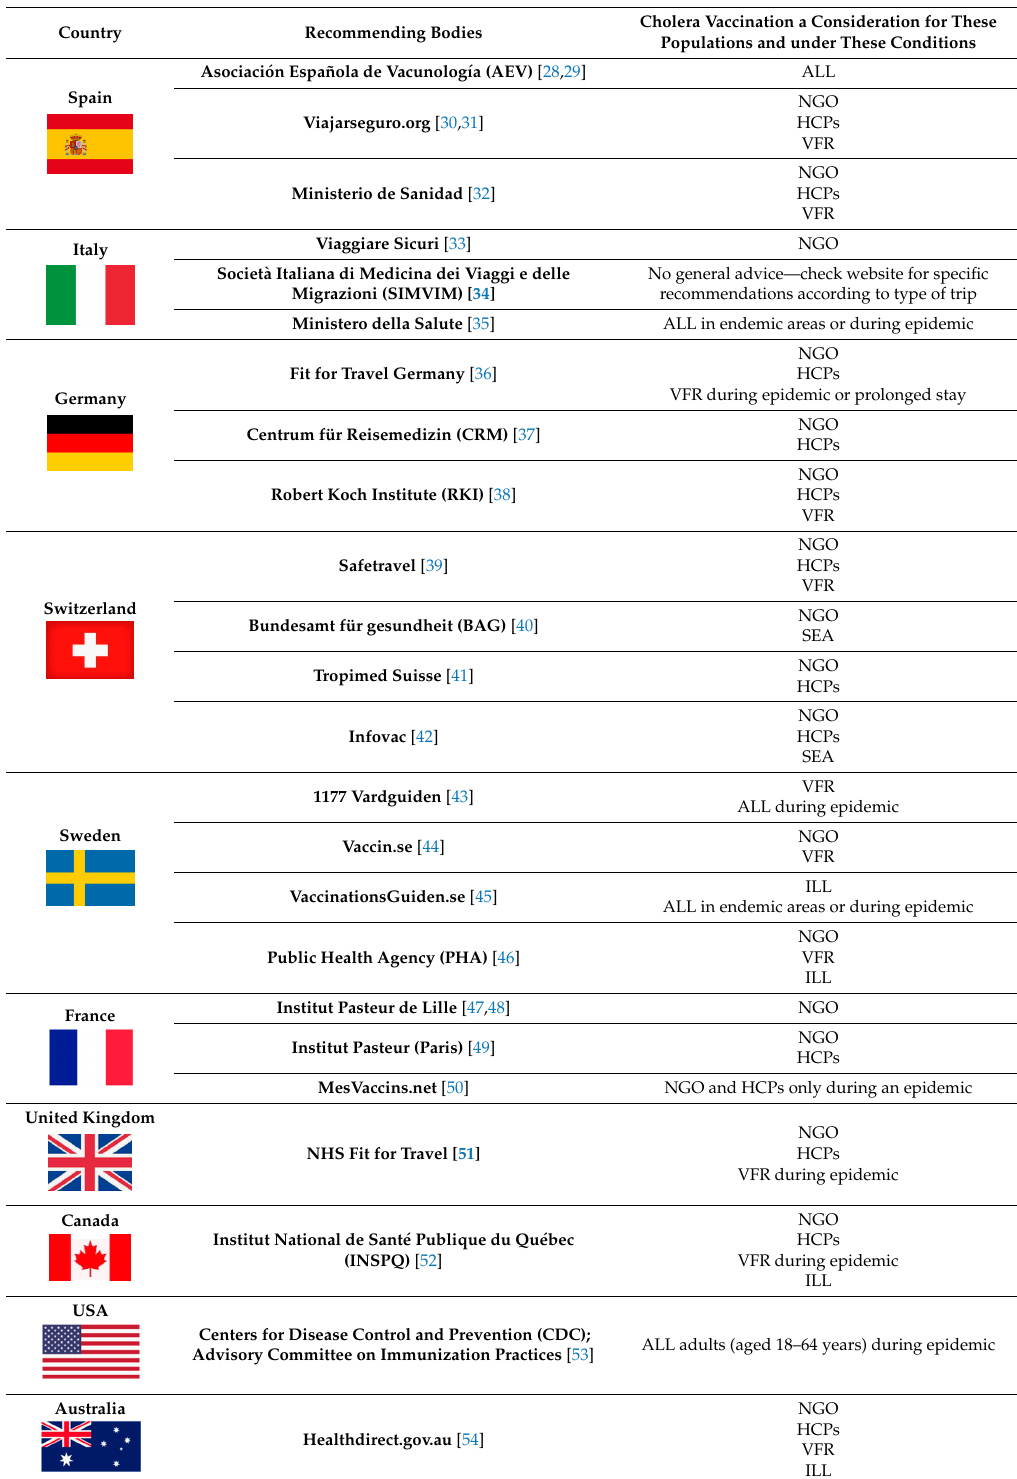
Table 1. Summary table of recommendations for travellers from the USA, Canada, Australia, and key European countries. Country